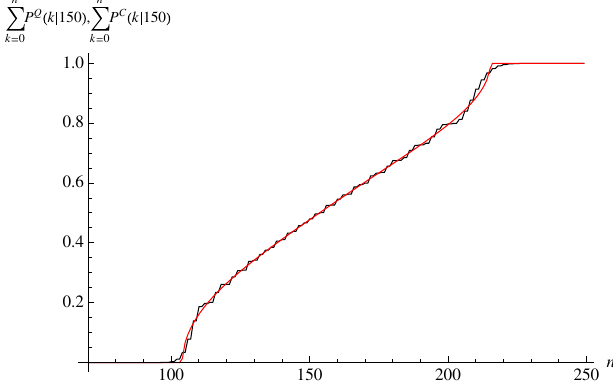
FIG. 3. Accumulated transition probabilities for the forced quartic oscillator. The jagged black curve represents the quantum P n P Q ð k j m Þ , while the smooth red curve represents the case, P k ¼ 0 n P C ð k j m Þ classical case, k ¼ 0